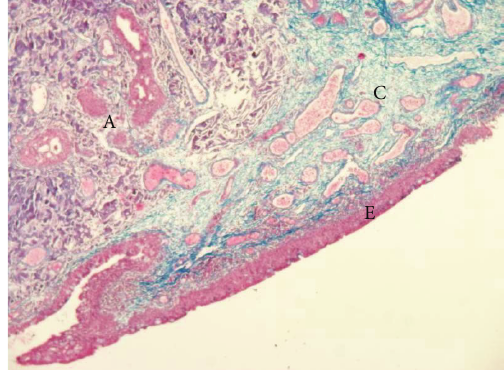
Figure 3: Photomicrograph of the biopsy specimen shows deposit of amyloid stained in gray- violet and collagen in blue (Mallory’s triple stain 50x). Conjunctival chorion shows waxy infiltration. Epithelium is not involved. E = conjunctival epithelium, A = amyloid, and C = connective